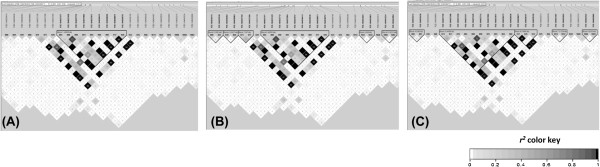
Haplotype blocks ranging from 37.41 Mb to 77.67 Mb on chromosome 4 as visualized in a 20-Mb sliding window on Haploview.A) Confidence intervals model, B) Four gamete rule and C) Solid spine of LD model. The inverted triangle represents haplotype blocks.